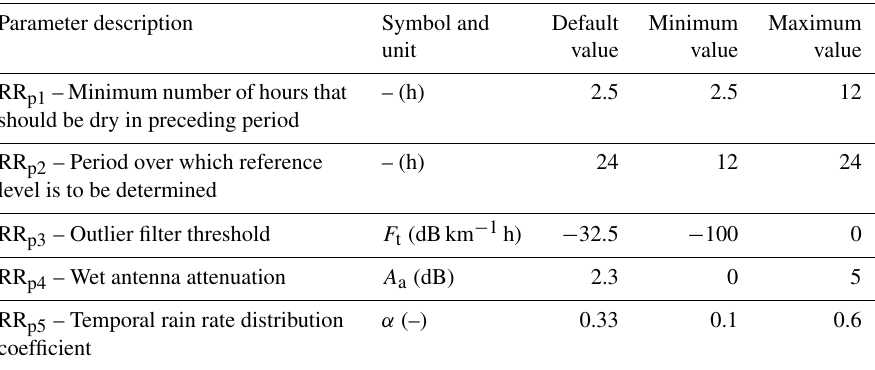
Table 2. Rainfall retrieval parameters (RR p n ): default values from RAINLINK and calibration search space (minimum and maximum values). Modified from Overeem et al.